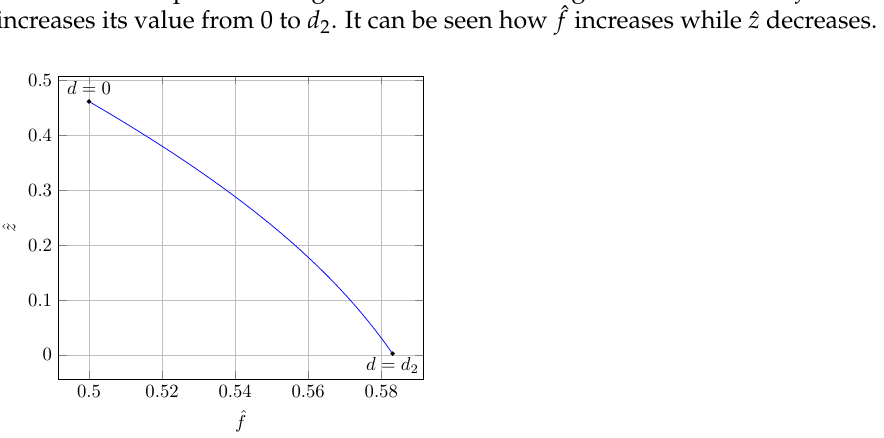
Figure 5. Interior equilibrium point ( ˆ f and ˆ z ) for increasing values of d . Observe that, when d increases, the value of ˆ f increases, and the value of ˆ z decreases. Parameters: n = 5, r = 3, σ = 1, and d 2 = ( n r ) / ( n σ + n r ) − −